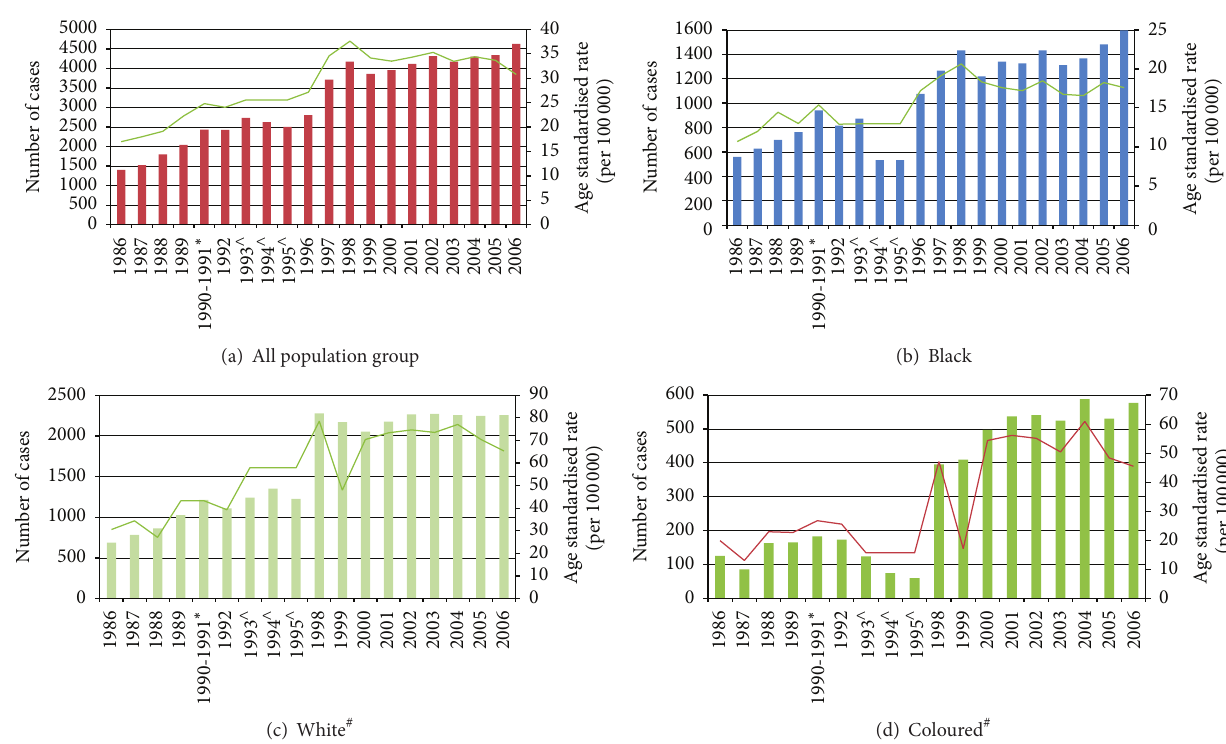
Figure 3: South African pathology based National Cancer Registry reported incidence of prostate cancer, 1988–2006. Columns: number of cases. Line: age standardised incidence rate (ASR). (a) All population groups; (b) black; (c) white; (d) coloured. ∧ 1993–1995 data was combined and the ASR is for the 3-year period. # 1996 and 1997 coloured and whites were pooled together and cannot be reported separately. ∗ Years 1990-1991 were combined and reflect the average number of reported cases over the two years. Asian/Indian population had less than 100 cases so not included here.